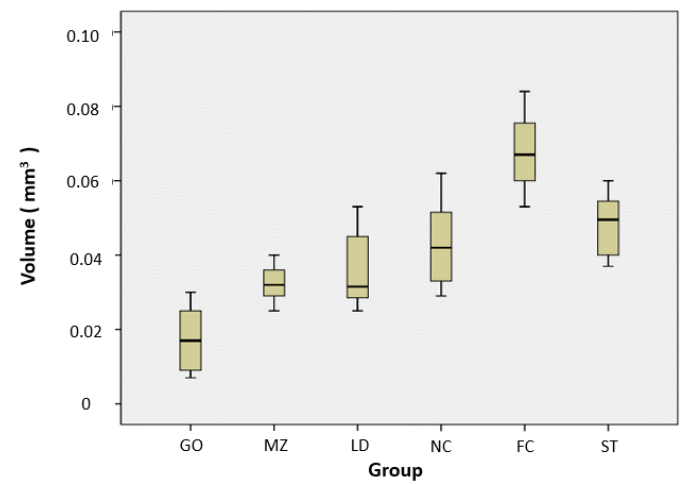
Figure 5. Volume loss distribution of resin teeth. GO, type III gold alloy group; MZ, monolithic zirconia group; LD, lithium disilicate glass ceramic group; NC, Ni–Cr alloy group; FC, feldspathic ceramic group; and ST, steatite group.